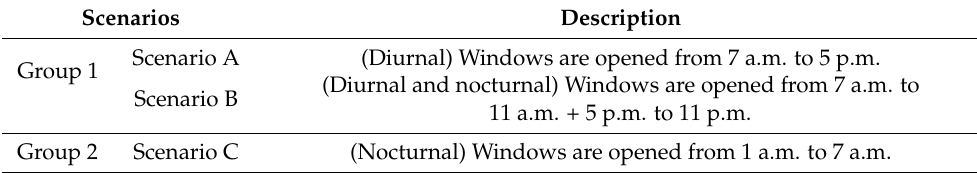
Table 4. List of mixed-mode cooling scenarios.